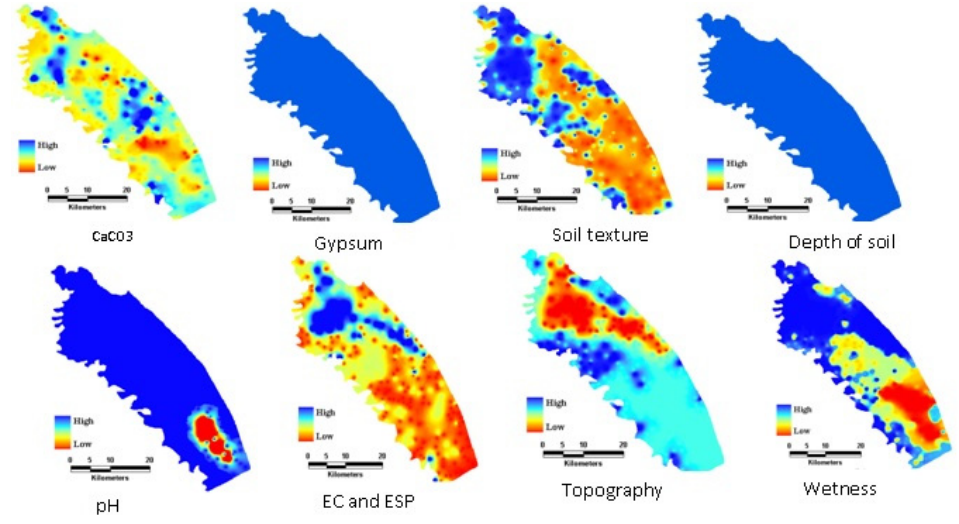
Figure 3. Fuzzy maps for each parameter.